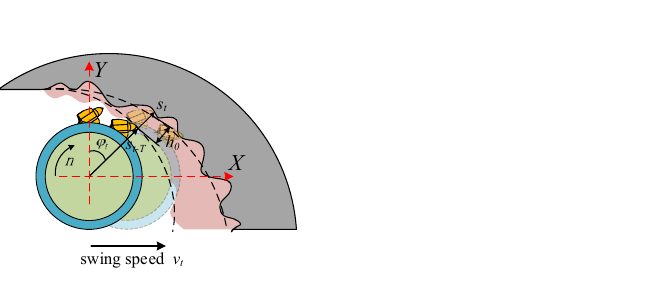
Figure 5. Dynamic model of cutting head system.